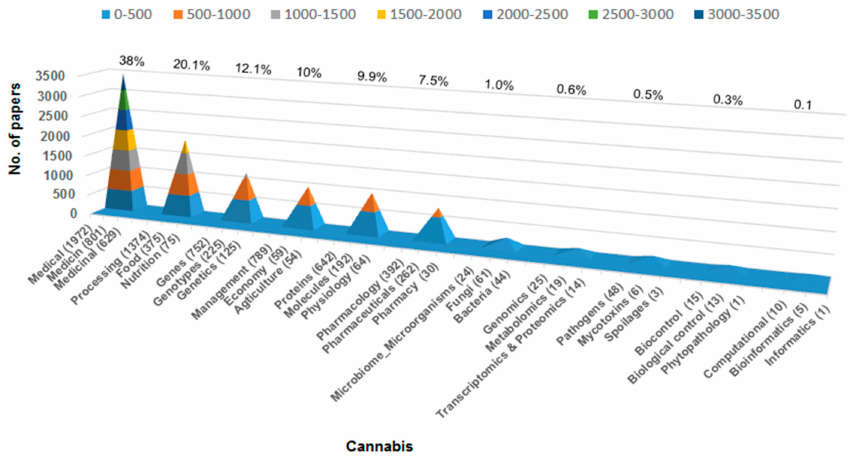
Figure 1. Web of Science data depicting published (1900–2018) articles on Cannabis related to major scientific domains (Data retrieved on 12 January